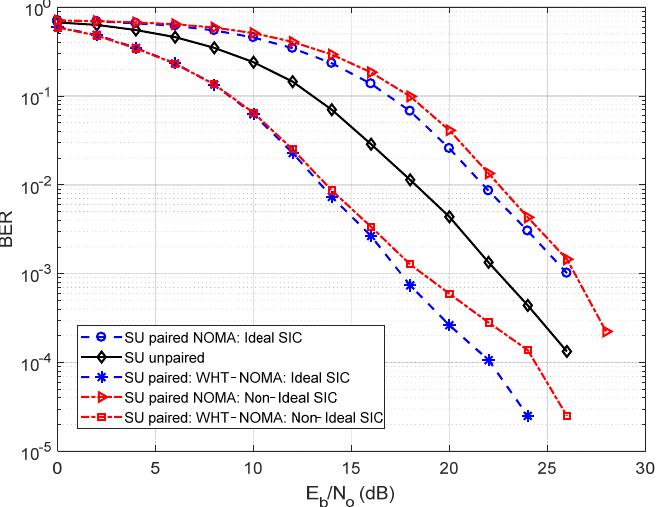
Figure 7. BER performance using QPSK modulation; NOMA vs. WHT–NOMA, power allocation: SU (SCU) = 0.4 and MU (SEU) = 0.6.